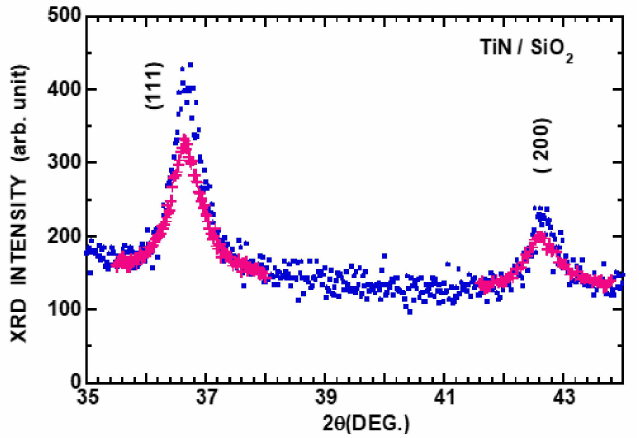
Figure 7. XRD patterns of TiN film on SiO 2 glass substrate: unirradiated ( • ) and irradiated by 100 MeV Xe at 0.72 × 10 12 cm − 2 ( + ).